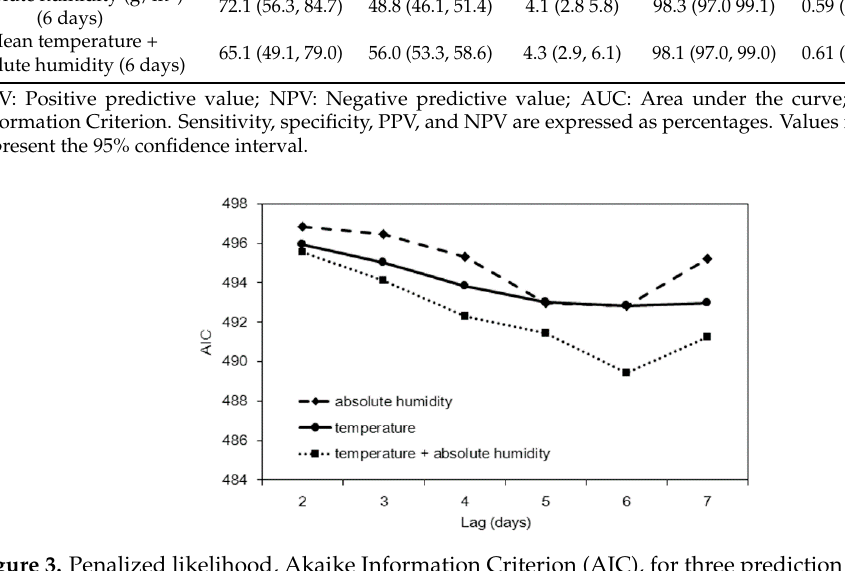
Figure 3. Penalized likelihood, Akaike Information Criterion (AIC), for three prediction models with different time lags. All three models were best fitted to the data with a time lag of six days.